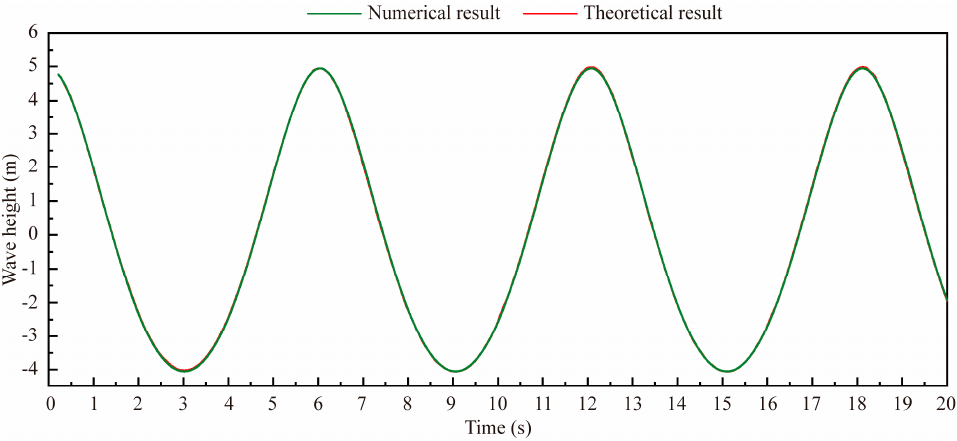
Figure 9. Numerical wave height with time history.